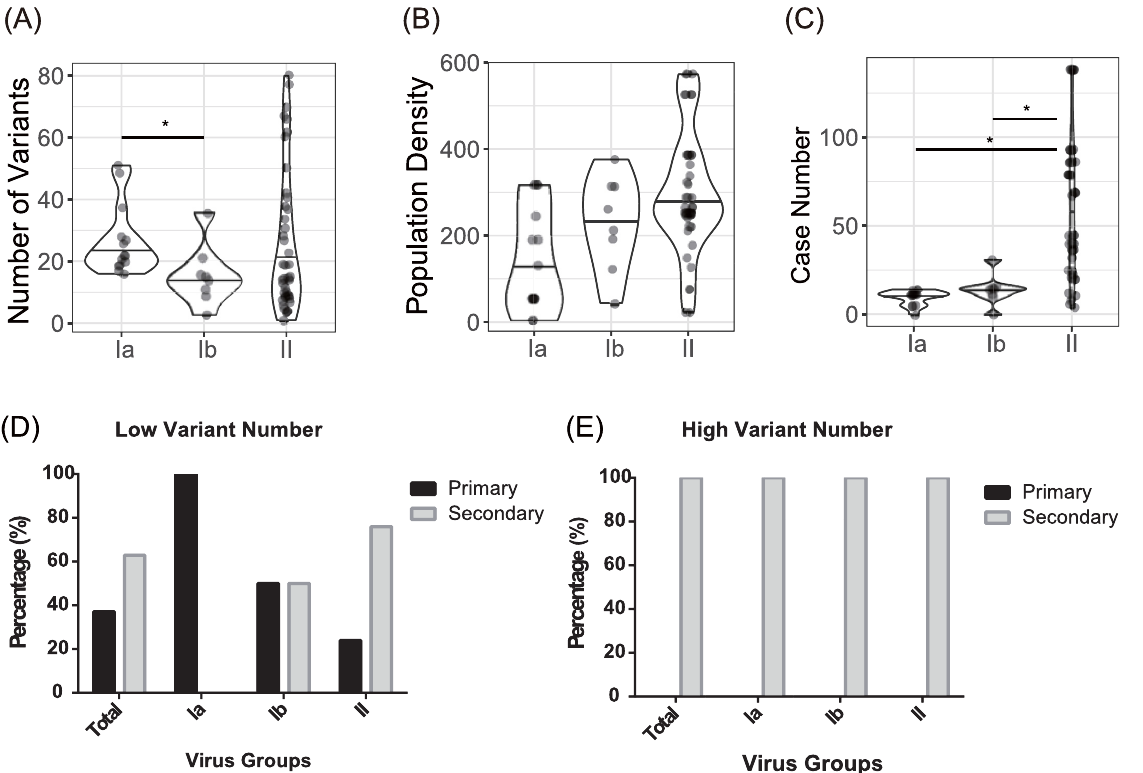
Fig 8. Factors associated with viral diversity: Population sizes, associated cases and population densities and secondary infection. (A) Distributions in the numbers of three groups of DENV-2 variants. The number of variants in group Ib was significantly lower than in group Ia viral variants. (B) Distribution of Li-specific population densities. (C) Li-specific numbers of dengue cases. Numbers of dengue cases associated with the group Ia and Ib variants were significantly lower than with group II. The Mann–Whitney–Wilcoxon test was used and significant differences (p < 0.05) were labeled with an asterisk. The horizontal bar in the middle of the violin plots indicates the median values of the three groups. Proportions of primary and secondary DENV infections within each group of viruses classified according to the numbers of the two groups: (1) low variant ( < 20) (D), and (2) high variant ( � 20) (E), boundary by medium value (medium is 20). (E). Primary DENV infection accounted for percentages of dengue cases in the low variant group, particularly in Ia variants. However, secondary DENV infection increased its percentages in the low variant groups of Ib and II viruses and eventually accounted for 100% of the secondary infection group for all the Ia, Ib and II groups with a high variant